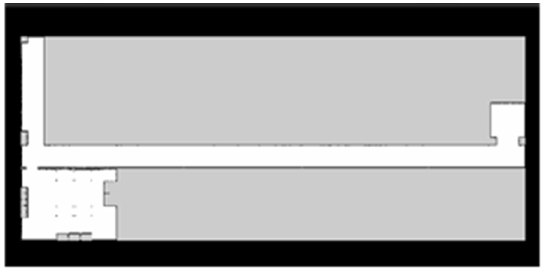
Figure 12. “Lab ‐ corridor” map. Figure 12. “Lab-corridor” map.